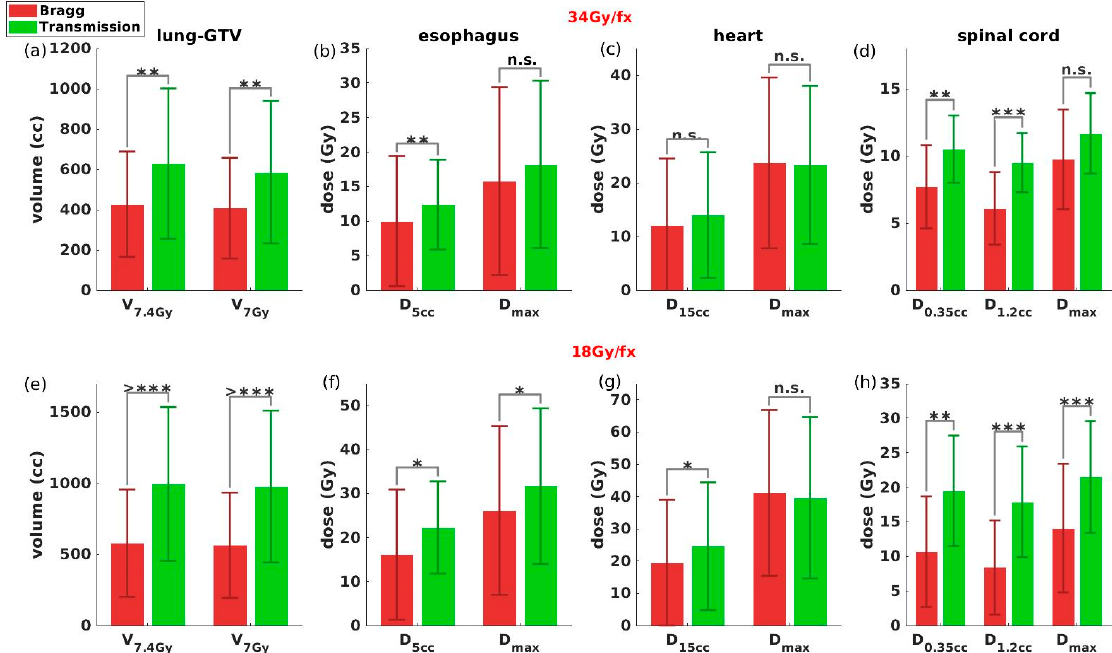
Figure 4. Barplots of dosimetry parameters for lung-GTV, esophagus, heart, and spinal cord in the 34G y/fx (( a )–( d )) and 18 Gy/fx (( e )–( h )) Bragg peak and transmission plans. * indicates p < 0.05, ** indicates p < 0.01, *** indicates p < 0.001, >*** indicates p < 0.0001, and n.s. indicates non-significant.